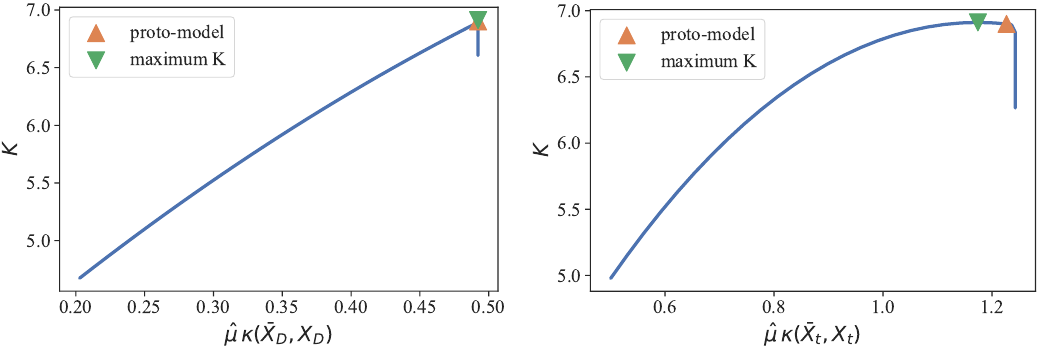
Figure 13 . As figure 12 but as a function of the proto-model’s signal strength multipliers. The sharp cut at large values is due to the constraint µ < µ